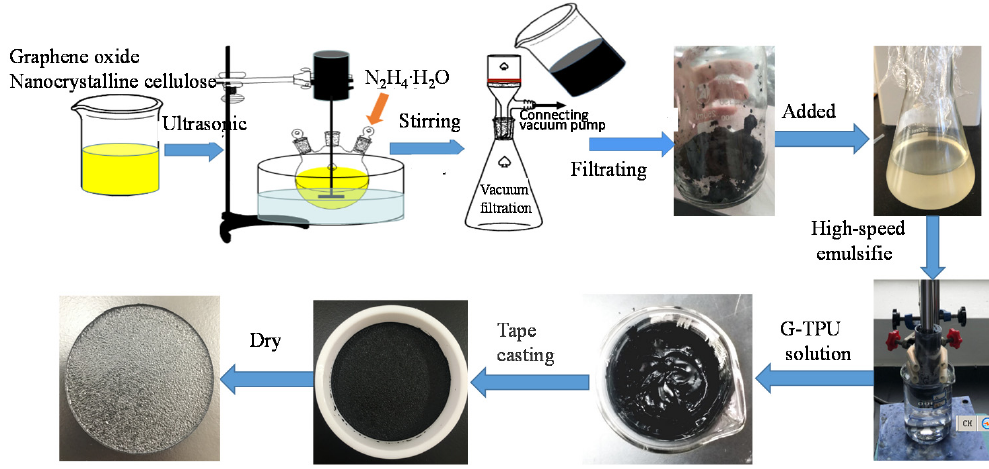
Figure 1. Schematic diagram of the fabrication process of the composite film.